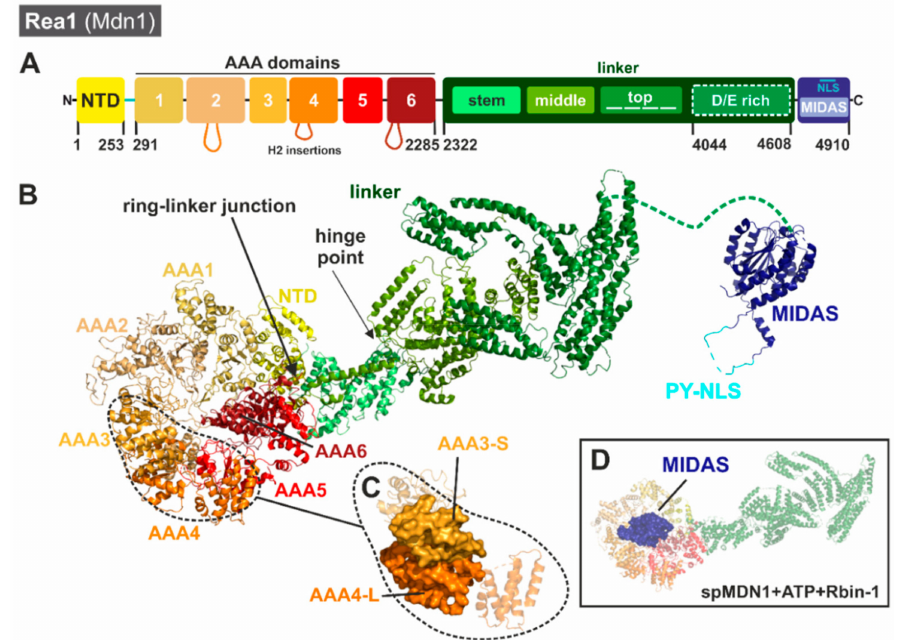
Figure 7. Structure of Rea1 / Midasin 1 (Mdn1). ( A ) Rea1 / Mdn1 is composed of a short N-terminal domain, followed by six adjacent AAA modules and the tail-like extension, all combined in one polypeptide chain. The linker is composed of a structured stem followed by a flexible D / E-rich region and connects the substrate-binding metal-ion-dependent adhesion site (MIDAS) domain to the AAA ring. The MIDAS domain also contains a PY-NLS needed to import Rea1 to the nucleus [126]. The six AAA modules that form the hexameric ring vary in size and partially contain additional helix insertions that can be involved in the interaction with the pre-ribosome [27]. ( B ) The AAA-domains and linker are taken from the cryo-EM reconstruction of S. cerevisiae Rea1 PDB ID: 6I26 [127] and the MIDAS domain from the recent crystal structure of the C. thermophilum MIDAS PDB ID: 6QT8 [126]. ( C ) Magnified interface created by two adjacent Rea1 AAA domains (AAA3-S and AAA4-L). ( D ) Weak density for MIDAS in contact with the ring detected in the cryo-EM reconstruction of S. pombe Mdn1 in the presence of ATP + Rbin-1 (PDB ID 6ORB)